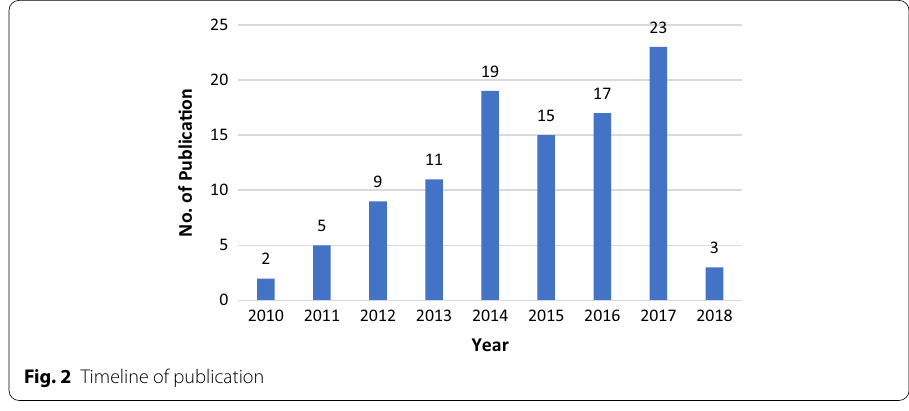
Fig. 2 Timeline of publication